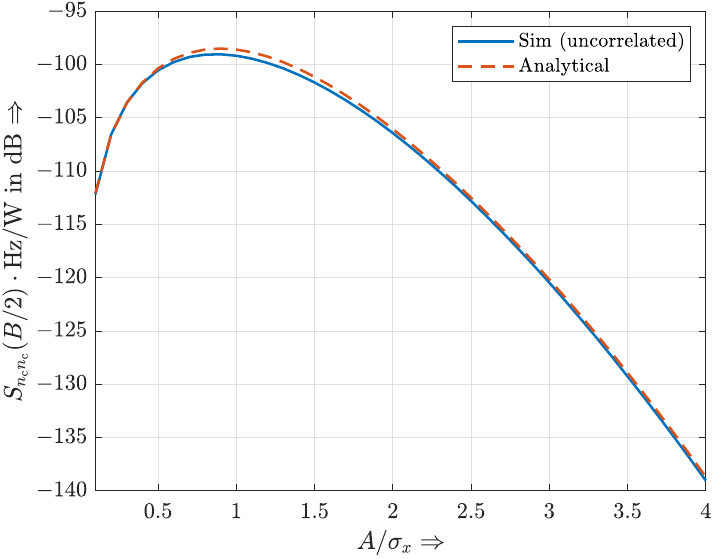
Figure 11. Analytically calculated versus simulated power spectral density of the clipping distortion evaluated at f = B /2 for σ 2 x = 1, B = 200 MHz and different clipping levels A